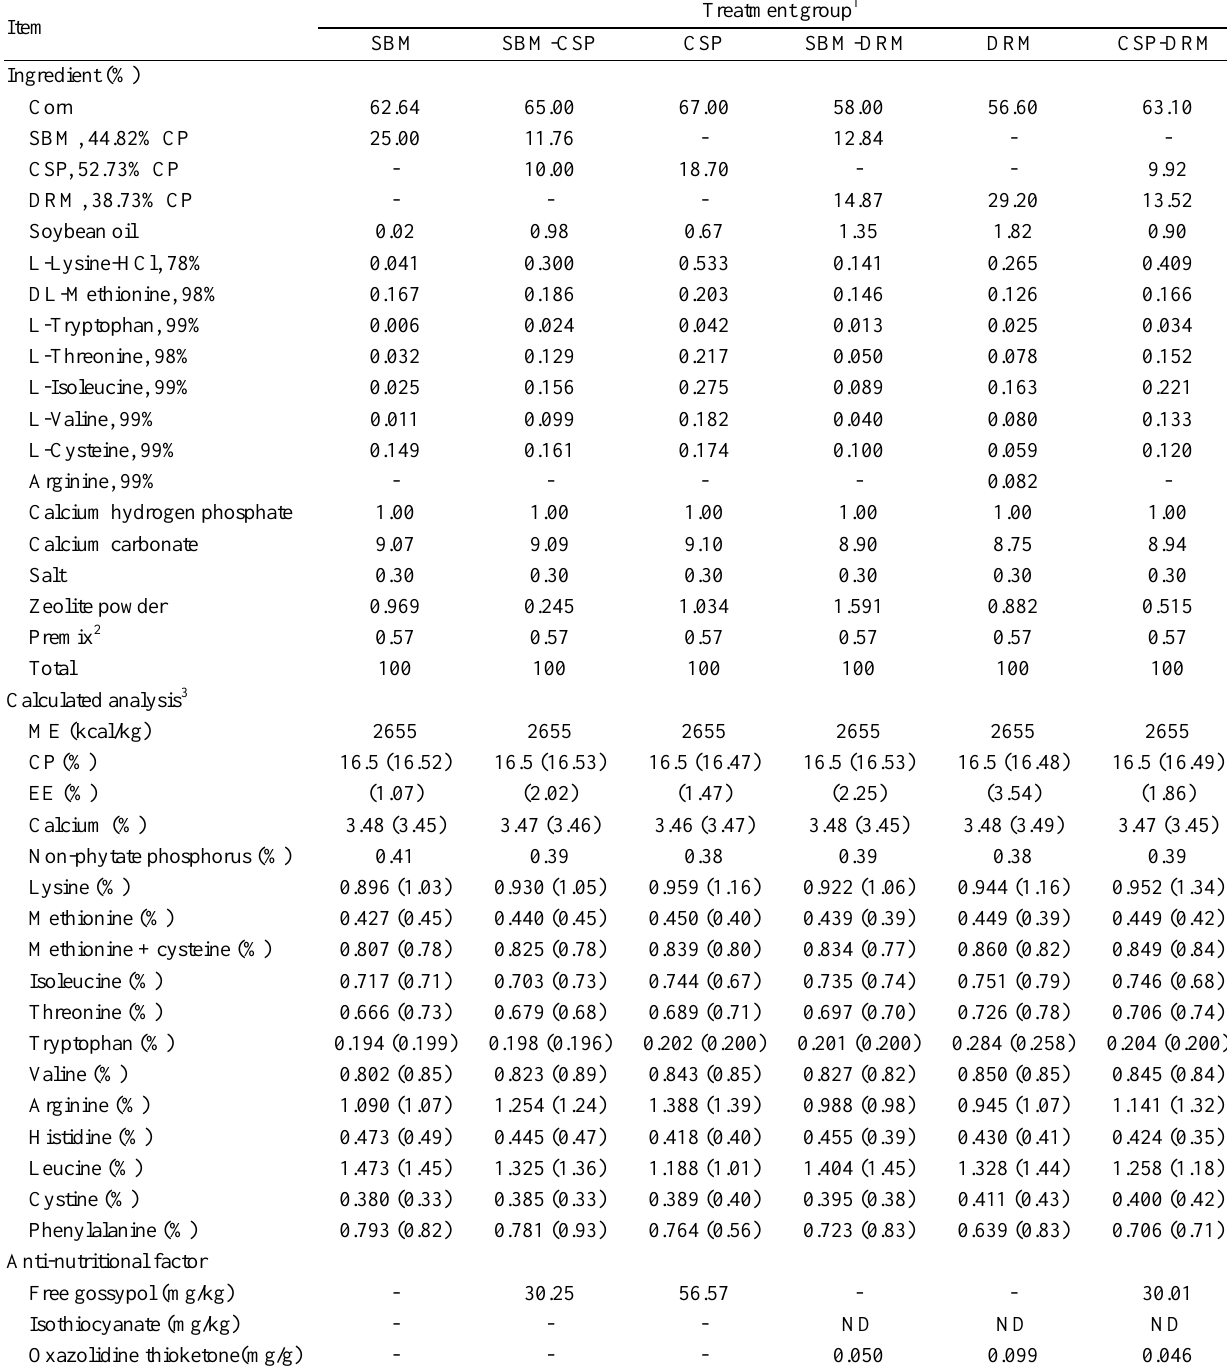
Table 1. Dietary composition and nutrient levels of the experimental diets (as-fed